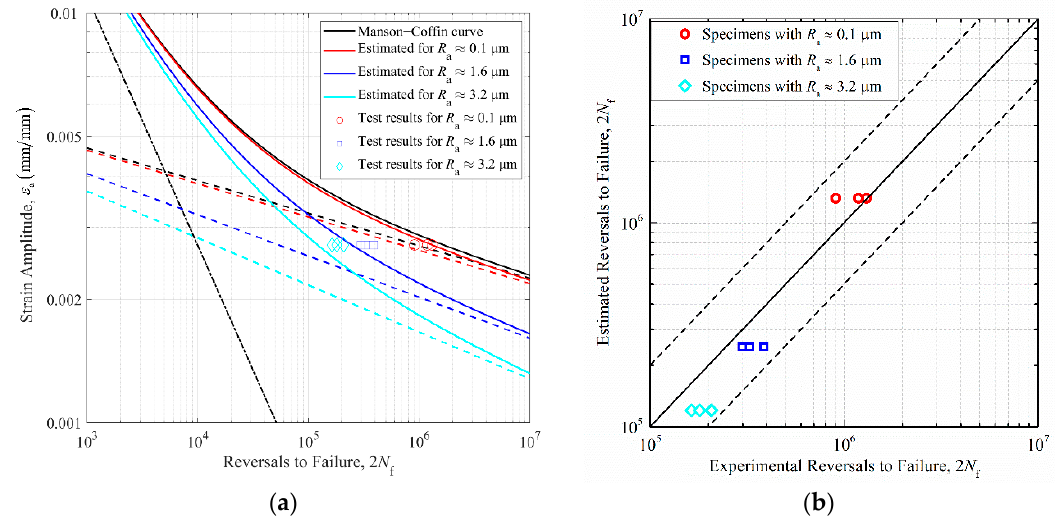
Figure 9. ( a ) Strain–life curve for 42CrMo steel and estimated curve for rough specimens based on correcting the elastic strain behavior using the average K fmax induced by surface topographies. ( b ) Estimated fatigue lives compared to experimentally obtained fatigue lives with the scatter bands of two.